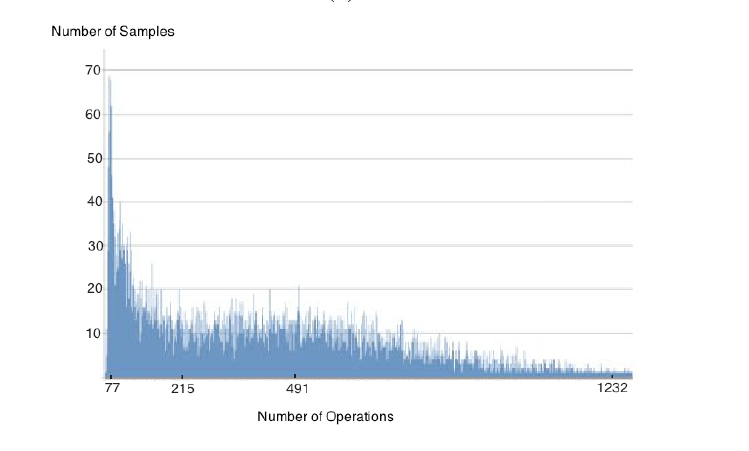
Figure 7. Behaviour unstable at the phase transition point ( m for n = 50 and m = 215 , m 4 . 3 ; ( c ) Distribution found for n = 200 and m = 860 , m